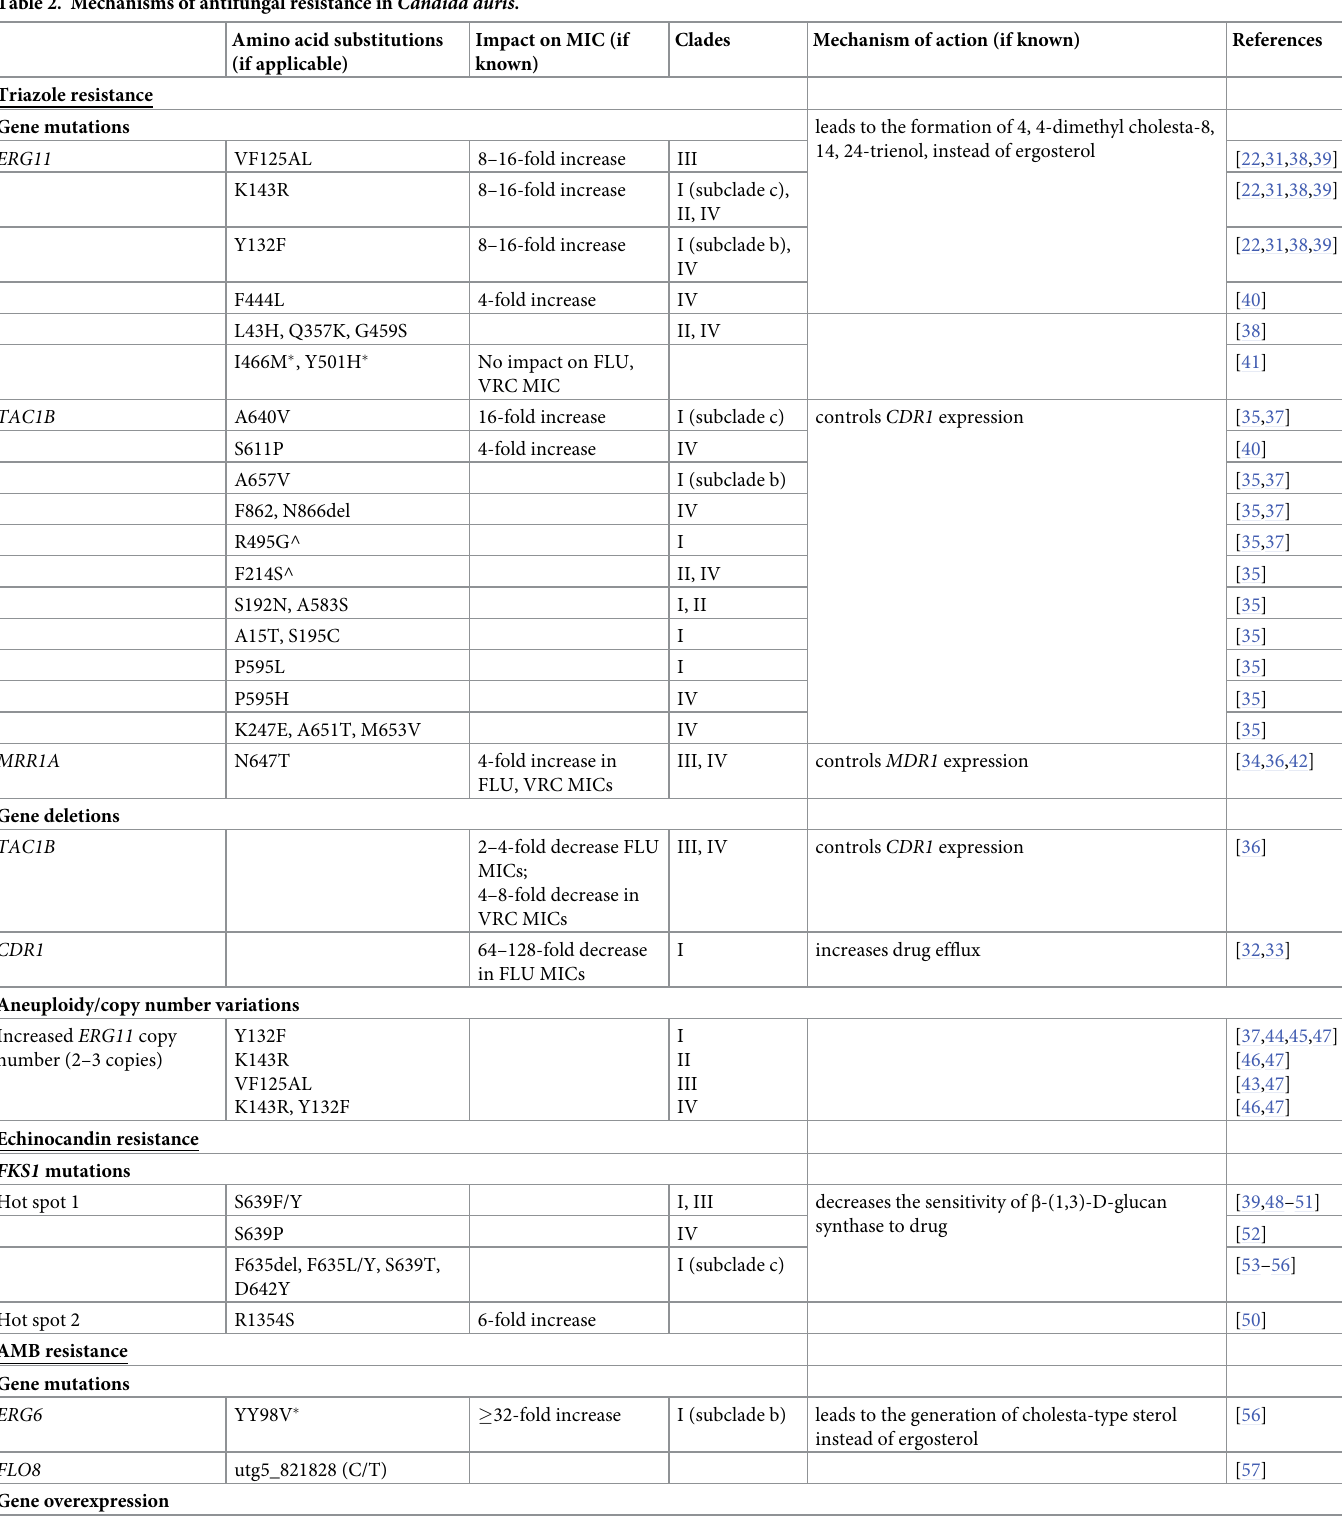
Table 2. Mechanisms of antifungal resistance in Candida auris